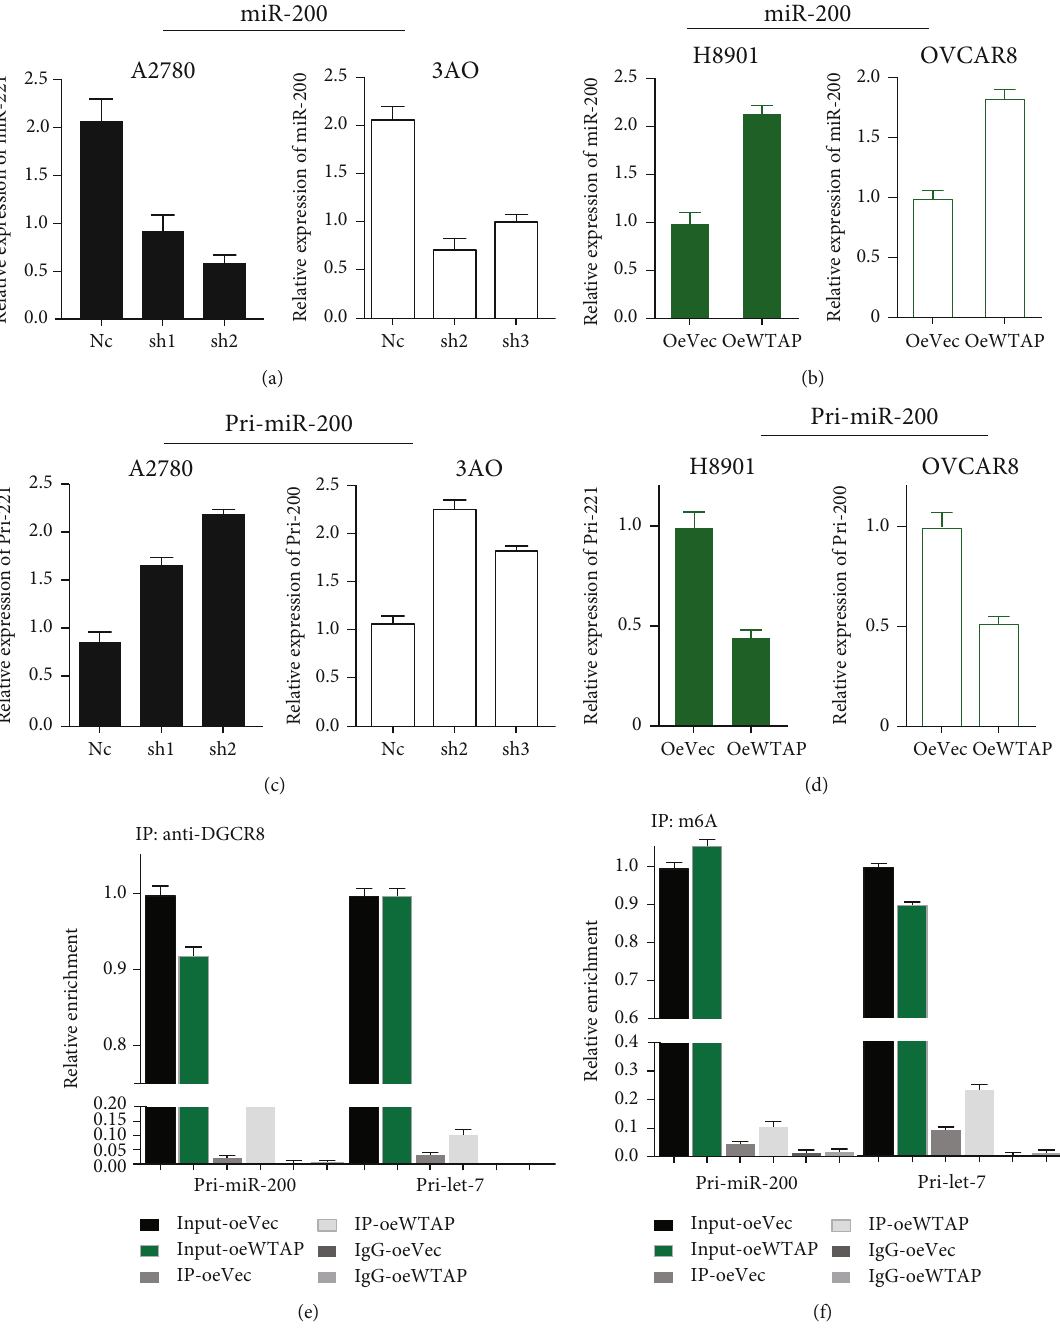
Figure 6: WTAP-dependent m6A demethylation regulates the processing of miR-200 via DGCR8. (a) MiR-200 was detected using RT- qPCR upon WTAP depletion or overexpression in A2780 and 3AO cells. (b) MiR-200 was quanti fi ed using RT-qPCR upon WTAP overexpression in H8901 and OVCAR8 cells. (c and d) pri-miR200 was detected by RT-qPCR upon WTAP depletion or overexpression in A2780/3AO and H8901/OVCAR8 cells. (e) Immunoprecipitation of DGCR8-associated RNA from control or WTAP-overexpressing cells followed by RT-qPCR to detect pri-miRNA binding to DGCR8. Pri-let-7e was used as a positive control. Three independent experiments were performed. (f) Immunoprecipitation of m6A modi fi ed RNA in control or WTAP-overexpressing cells followed by RT- qPCR to estimate the m6A modi fi cation levels of pri-miRNAs. IgG = immunoglobulin G; IP = immunoprecipitation; oe =